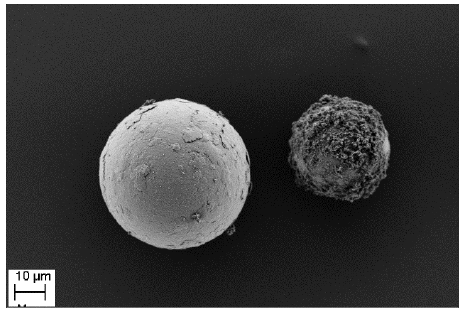
Figure 11. SEM images of the post-treated (with magnetic stir bar, after 12 h) SMGS Type S (Experiment 2 A). Partially, a significant change in morphology takes place.